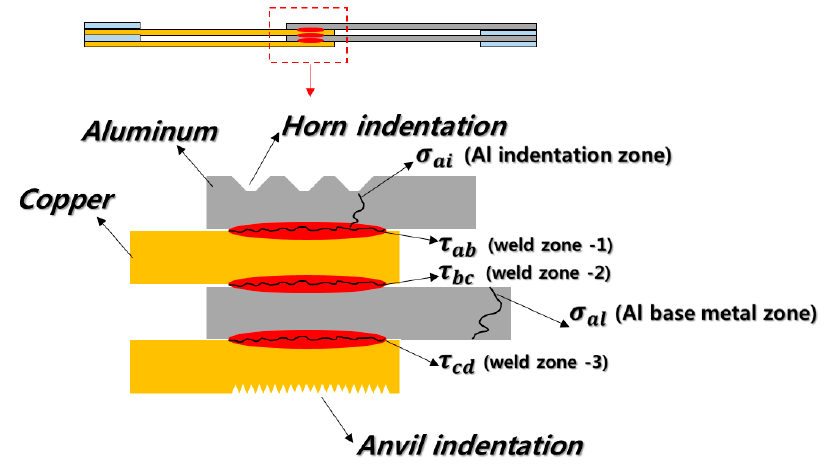
Figure 6. Three zones of the ultrasonic weldment of multi-layer, dissimilar materials Al and Cu.